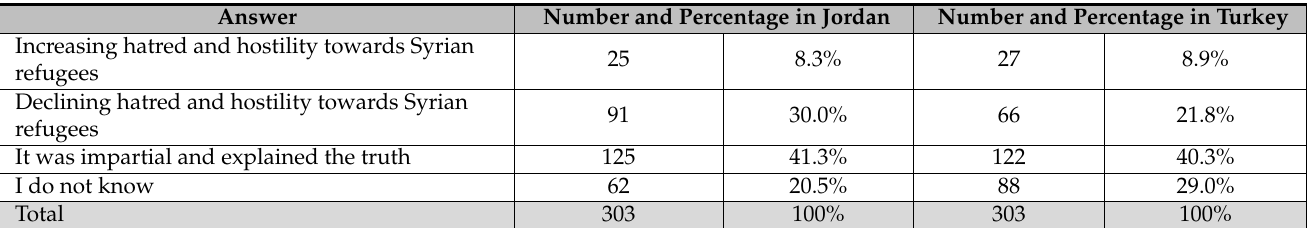
Table 4. The Participants Opinions on the Effects of Social Media (Facebook, Twitter, YouTube, etc.) in Conveying the Image of Syrian Refugees.